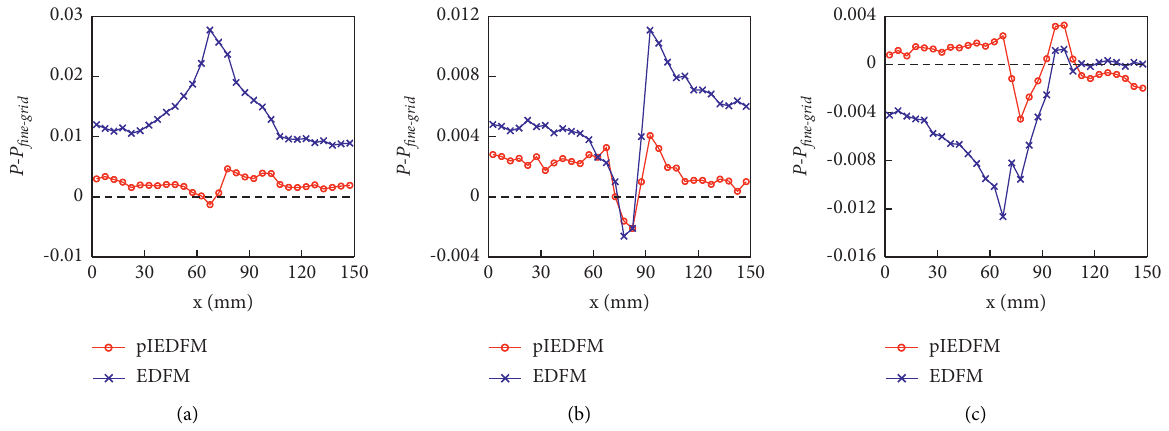
Figure 19: Oil pressure errors in the (a) lower edge, (b) center, and (c) upper edge slices.